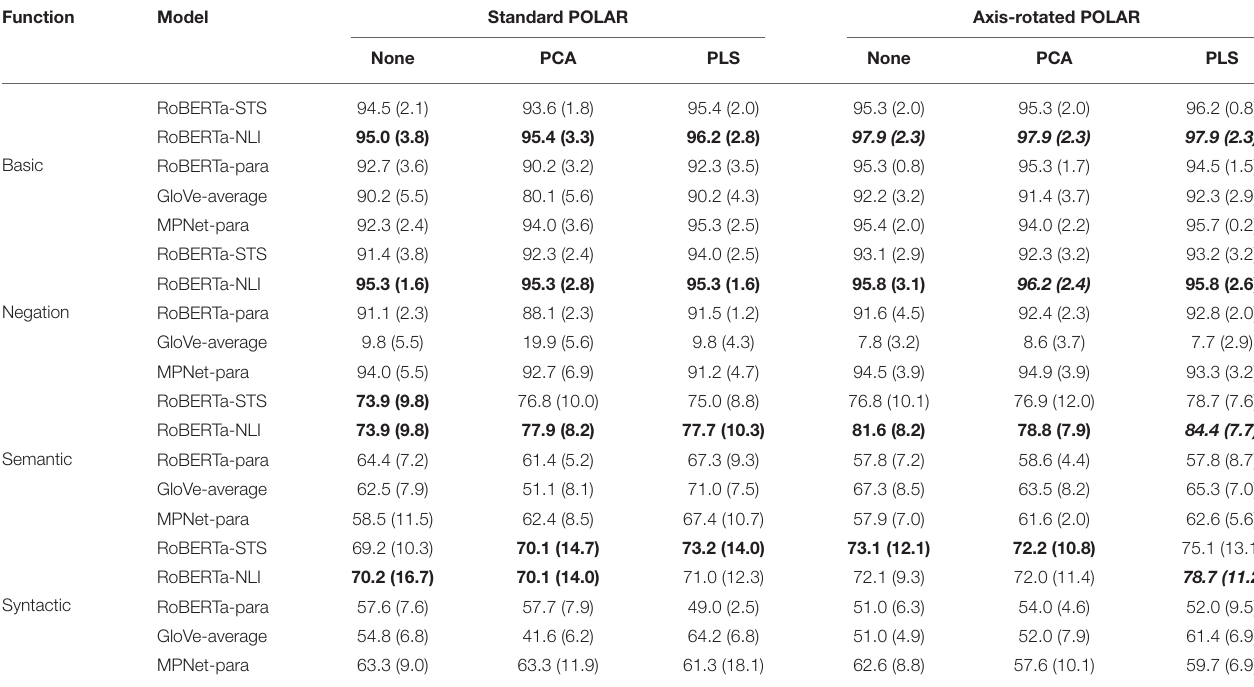
cross-validation procedure as in Section 3.1.3, using 80% of the seed words to generate training sentences, and reserving 20% for testing in each fold. At the end of the cross-validation procedure, we have warmth and competence scores associated with a test sentence for every word in the seed lexicon; we